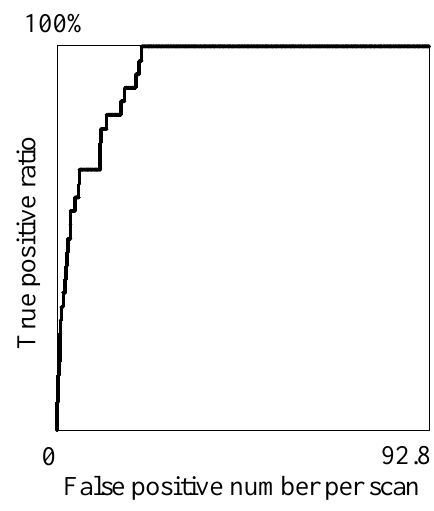
Figure 5. The fROC curve of the proposed